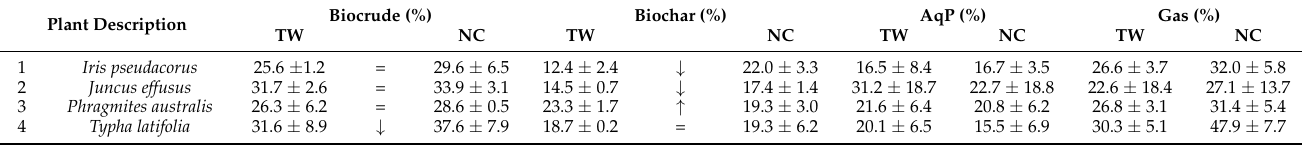
Table 3. Fraction yields for all the selected plant for the different growing environments after HTL reaction. Plant